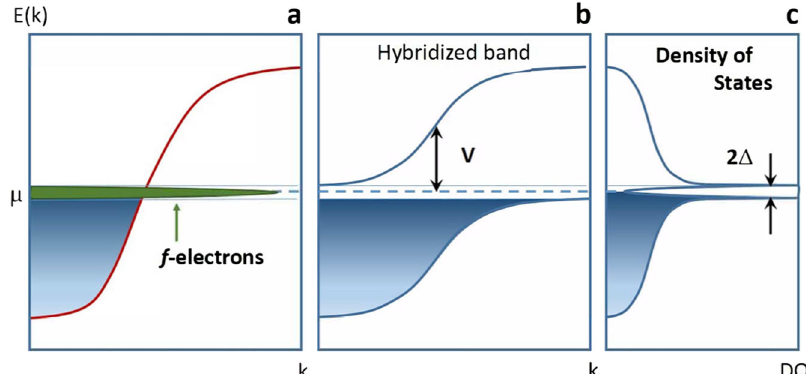
Fig. 1 Formation of a hybridization gap. a Conduction electron band (red) and weakly dispersive f -electron band (green) in the absence of a hybridization gap. b Hybridization bands forming at low temperatures, where V is the hybridization potential. c Indirect gap 2 Δ separating peaks in the electronic density of states.